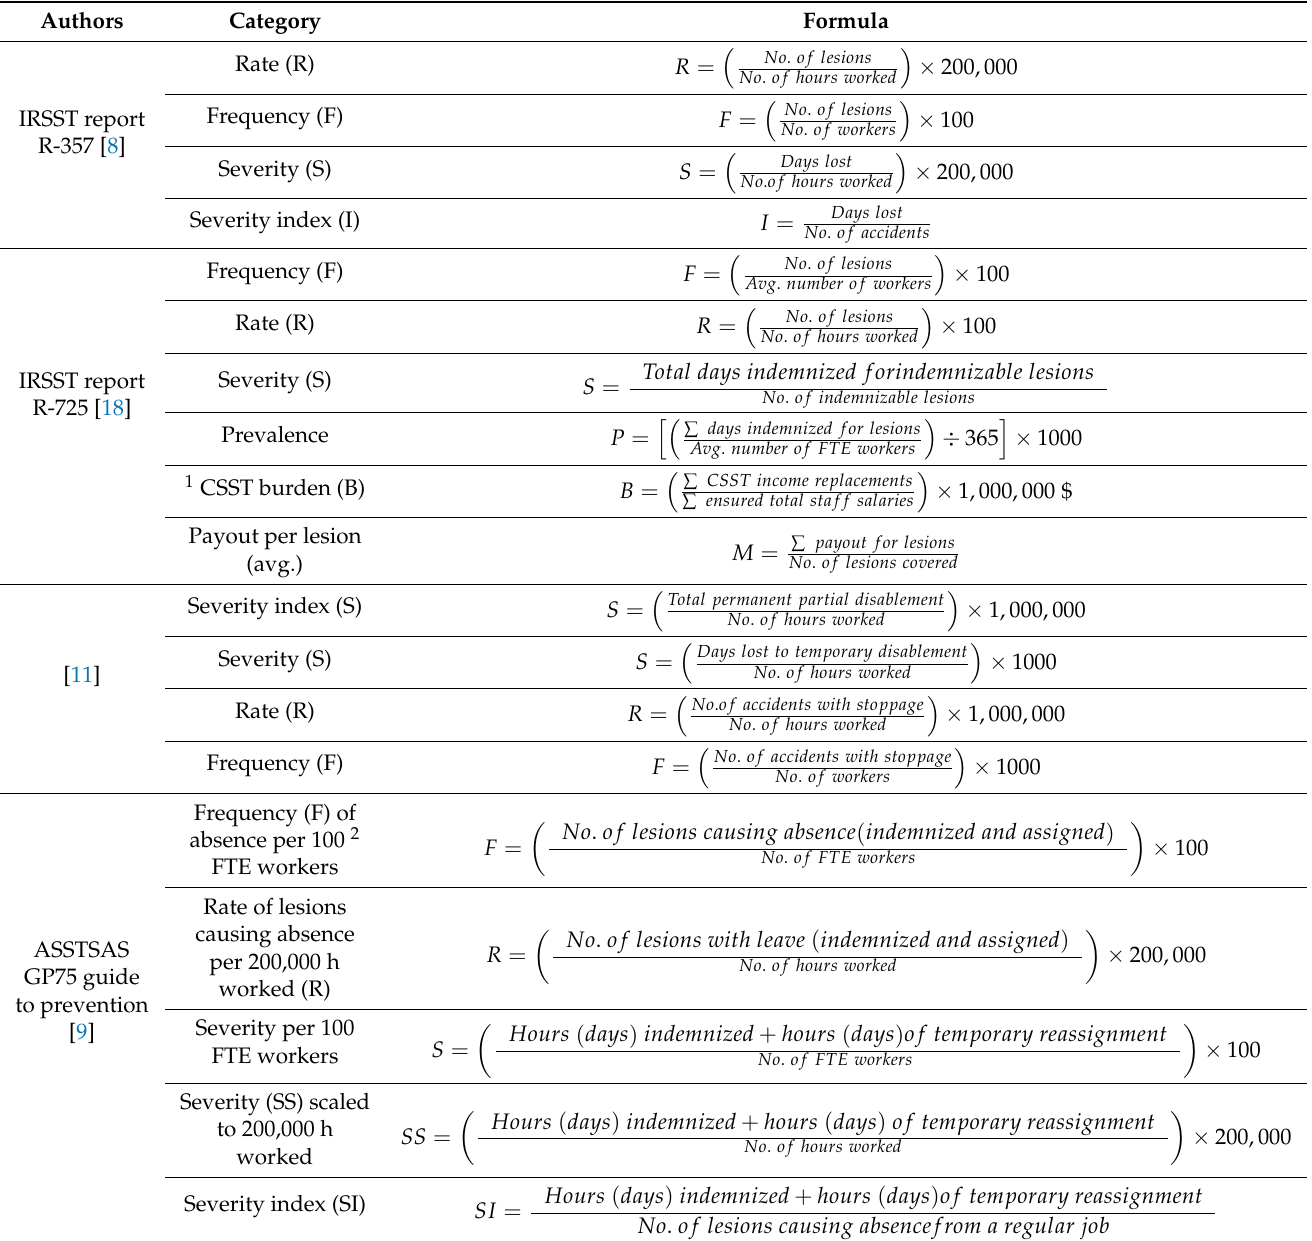
Table 1. Reactive indicators described in the scientific